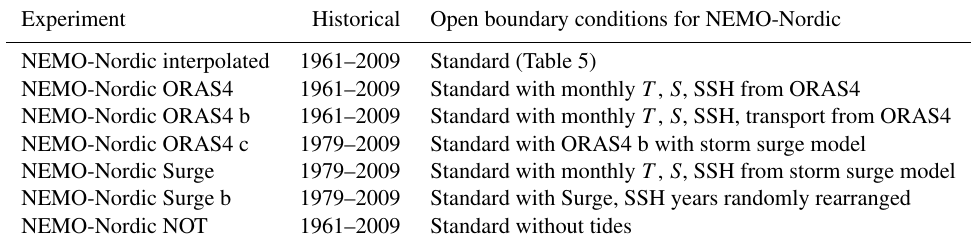
Table 6. Sensitivity runs forced with RCA4 ERA40. The runs differ from each other by the open boundary conditions that have been applied at the open boundaries of NEMO-Nordic. All runs in this table are ocean-only experiments. These sensitivity runs have been described in more detail in Dieterich et al. (2019a). ORAS4 stands for Operational Ocean Reanalysis System 4 and has been evaluated by Balmaseda et al.